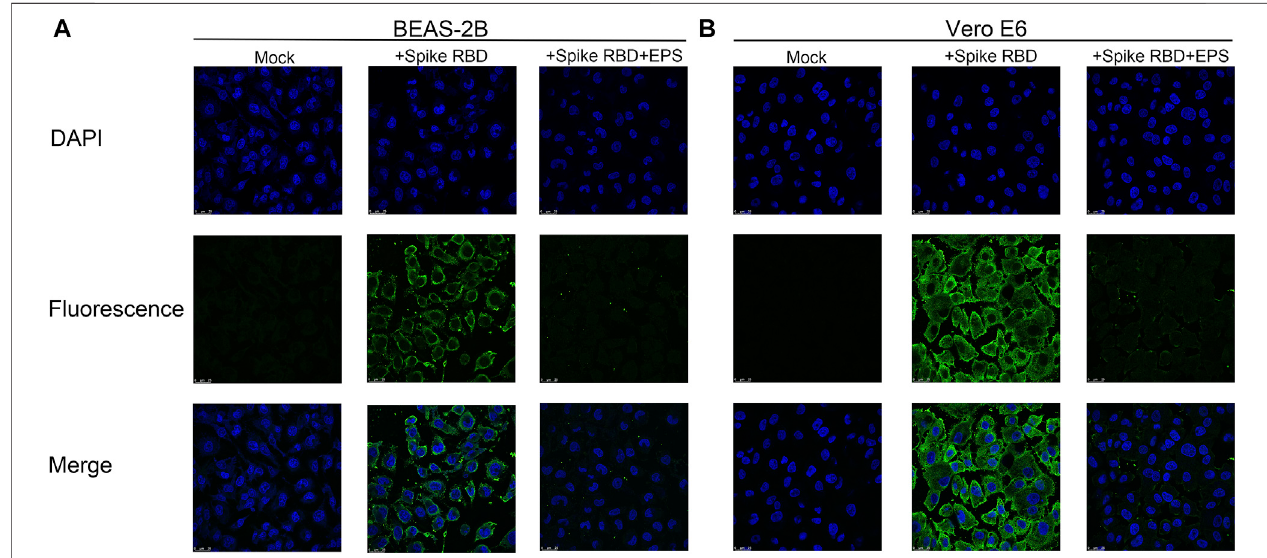
FIGURE 2 | Immuno fl uorescence assay of EPSs from H. hispanica -blocking RBD to bind with BEAS-2B and Vero E6. (A) Binding of RBD to BEAS-2B cells inhibited by EPSs from H . hispanica . (B) Binding of RBD to Vero E6 cells inhibited by EPSs from H. hispanica . Mock : cells detected in the absence of RBD and EPSs; + Spike RBD : cells detected in the presence of RBD (1 μ g/well); and + Spike RBD + EPSs : cells detected in the presence of RBD (1 μ g/well) and EPSs (2 μ g/well). All wells were detected by immuno fl uorescence using SARS-CoV-2 (2019-nCoV) spike-neutralizing antibody and Alexa Fluor 488 goat anti-mouse IgG (H + L) by using a confocal microscope. The fl uorescence signals were captured with an FITC channel, and the nuclear DNAs of cell were stained with DAPI.